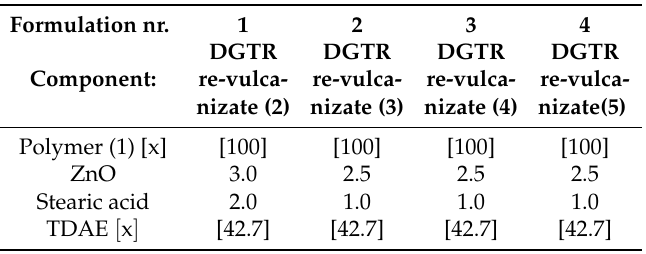
Table 3. Revulcanization formulations, values in